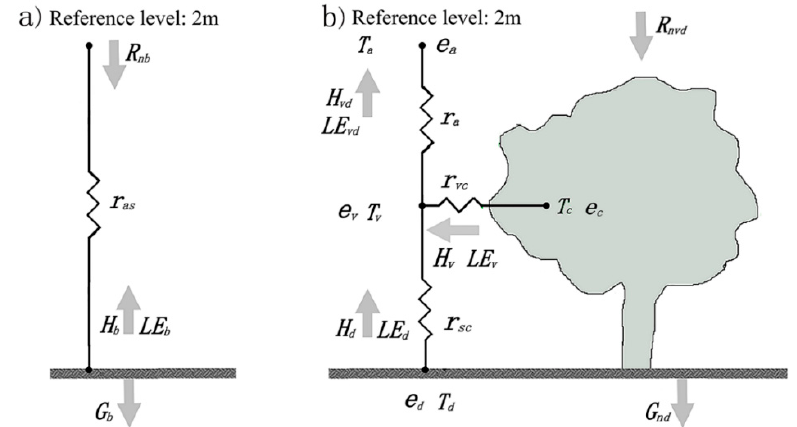
Figure 5. The demonstration of resistance network and important energy balance variables used in ( a ) bare soil and ( b ) the two-source energy balance (TSEB) model (Note: R nb and R nvd (R nd + R nv ) represent, respectively, surface net radiance flux under bare soil and vegetation cover; R nd and R nv are the surface net radiance flux of the shaded soil and vegetation. H b , H d , and H v represent, respectively, the surface sensible heat flux of bare soil, shaded soil, and vegetation. H vd is the sum of H v and H d . LE b , LE d , and LE v represent, respectively, the surface latent heat flux of bare soil, shaded soil, and vegetation. LE vd is the sum of LE v and LE d . G b and G d represent, respectively, the surface flux exchange of bare soil and shaded soil. T a , T d , and T c are the atmospheric temperature at the reference level, the surface soil temperature, and the vegetation aerodynamic temperatures, respectively. The r as , r vc , and r sc represent, respectively, the aerodynamic resistance, the resistance of the whole canopy boundary layer, and the aerodynamic resistance between canopy source and soil surface. e a , e c , and e d represent, respectively, the water vapor pressure at the reference level, canopy height, and soil surface).